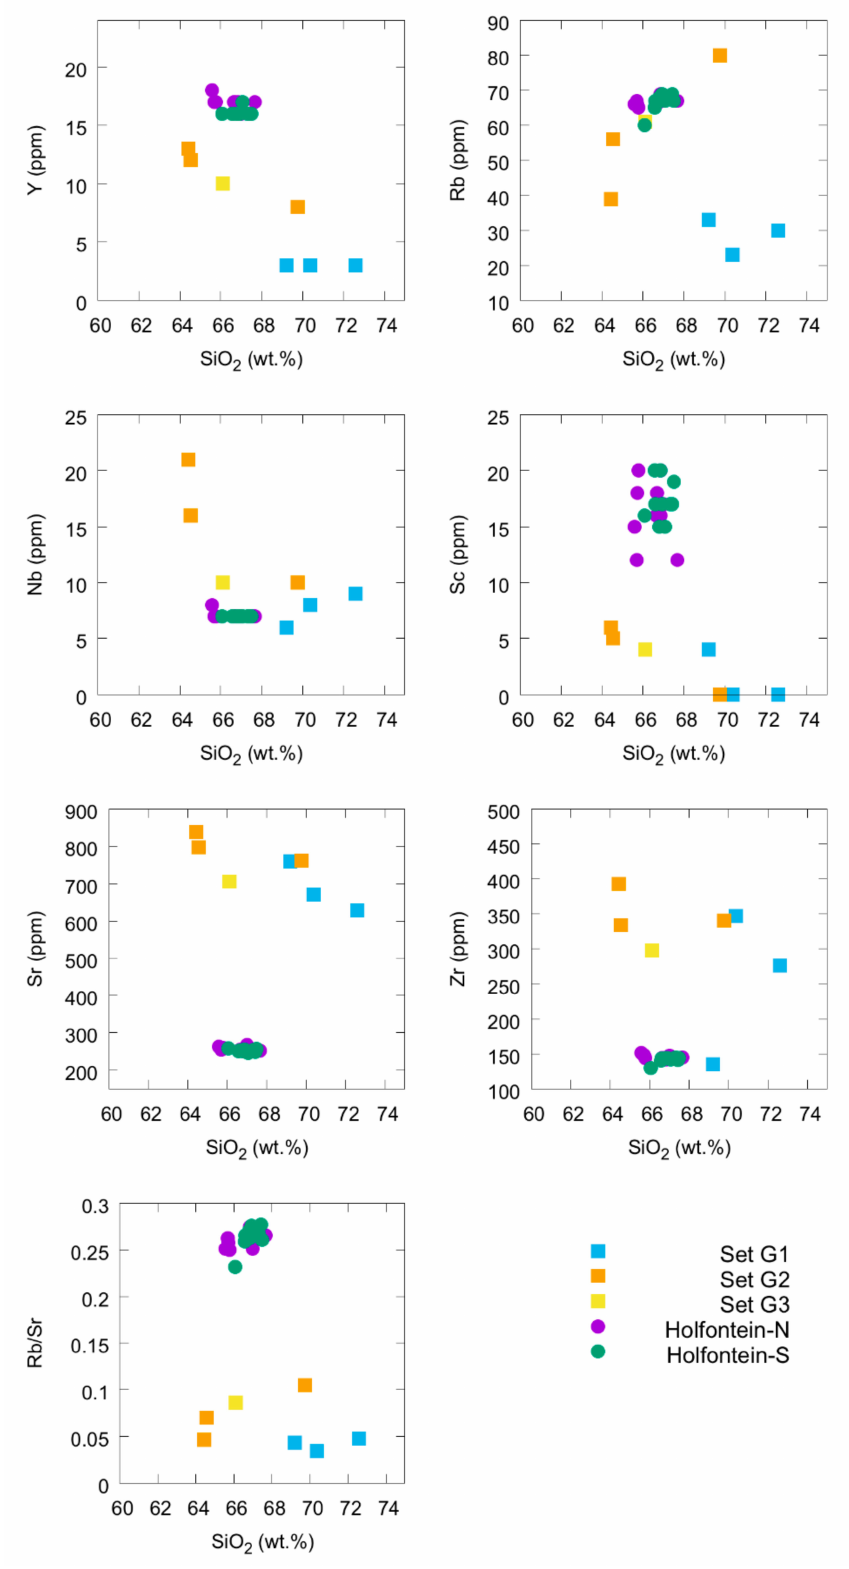
Figure 13. Granophyre and host granite trace element compositions vs. SiO 2